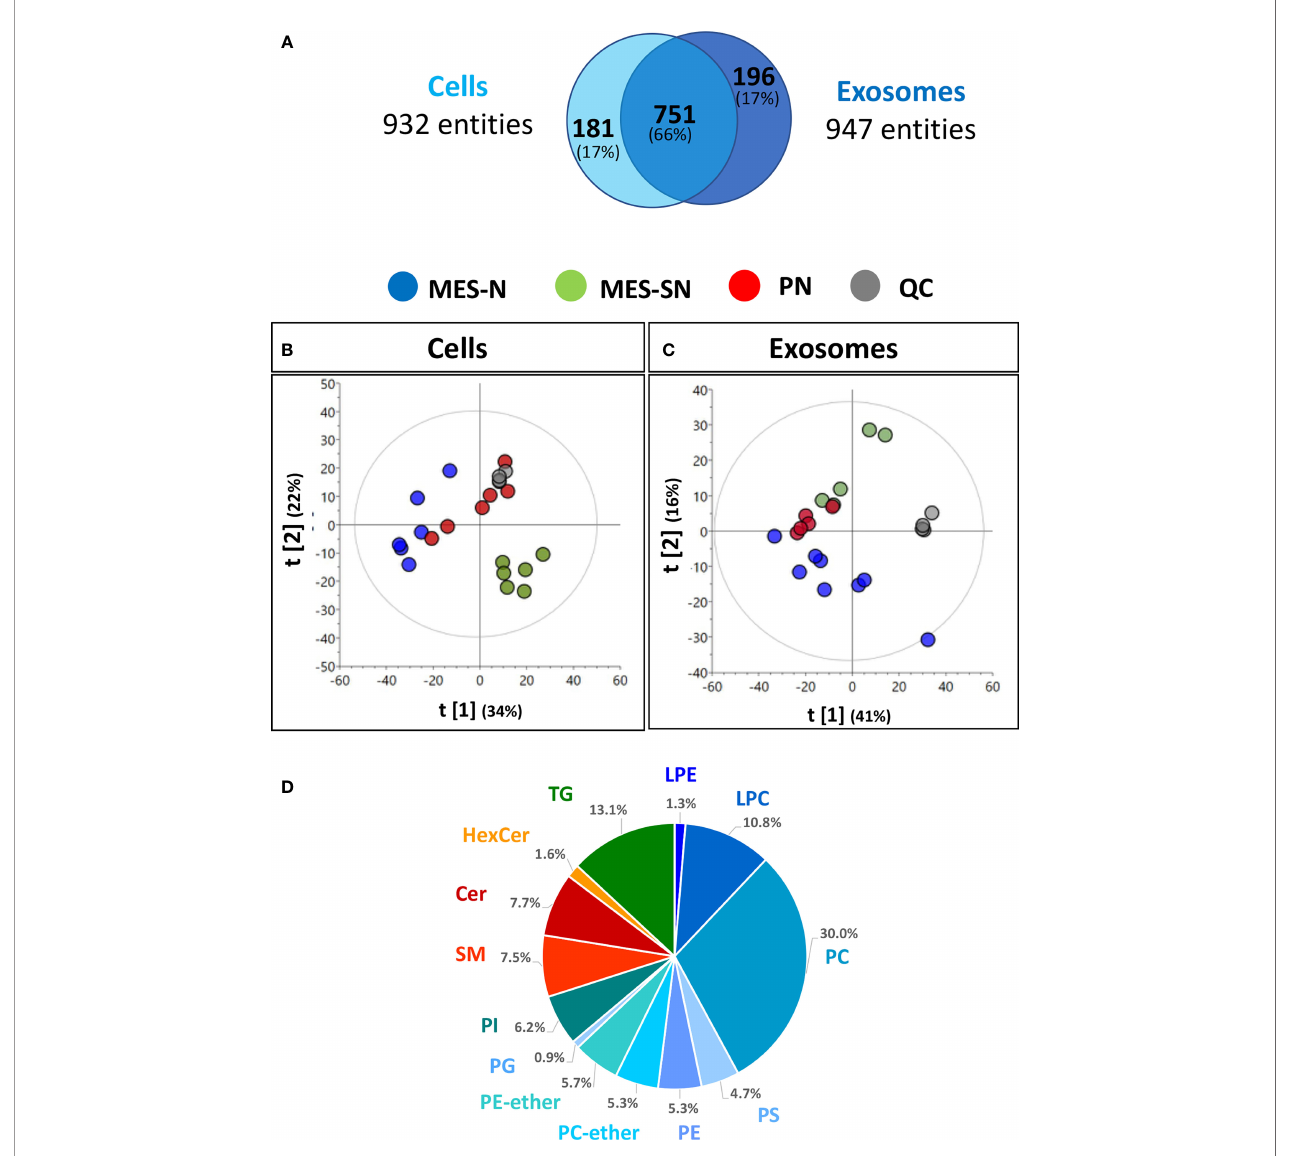
FIGURE 1 | Metabolic pro fi le description of GSC phenotypes from cells and their derived exosomes. (A) Chemical entities in cells and exosomes that passed the quality fi lters, (B, C) Principal component analysis (PCA) models of cells and exosomes: quality control injections (QC, (cid:129) dark-gray dot), MES-N ( (cid:129) ; blue dot), MES-SN ( (cid:129) ; green dot), and PN ( (cid:129) ; red dot). Unit variance scaling was used for both models. (D) Pie chart showing the percentages of the number of lipid classes for cells. LPE, lysophosphatidylethanolamines; LPC, lysophosphatidylcholines; PC, phosphatidylcholines; PS, phosphatidylserines; PE, phosphatidylethanolamines; PC-ether, ether-phosphatidylcholines; PE-ether, ether-phosphatidylethanolamines; PG, phosphatidylglycerols; PI, phosphatidylinositols; SM, sphingomyelins; Cer, ceramides; HexCer, hexosylceramides; TG,